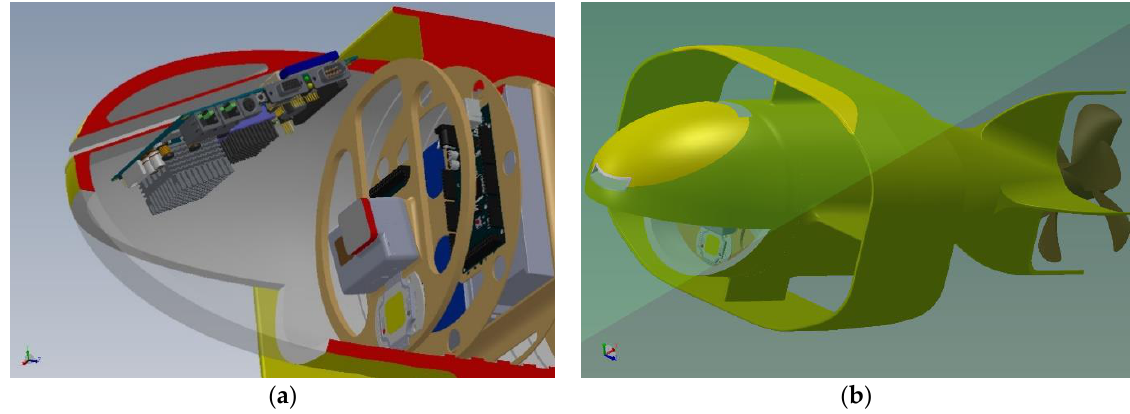
Figure 4. ( a ) The payload and navigation bay: cutaway side view; ( b ) drone in “nose up” attitude: prospective view.